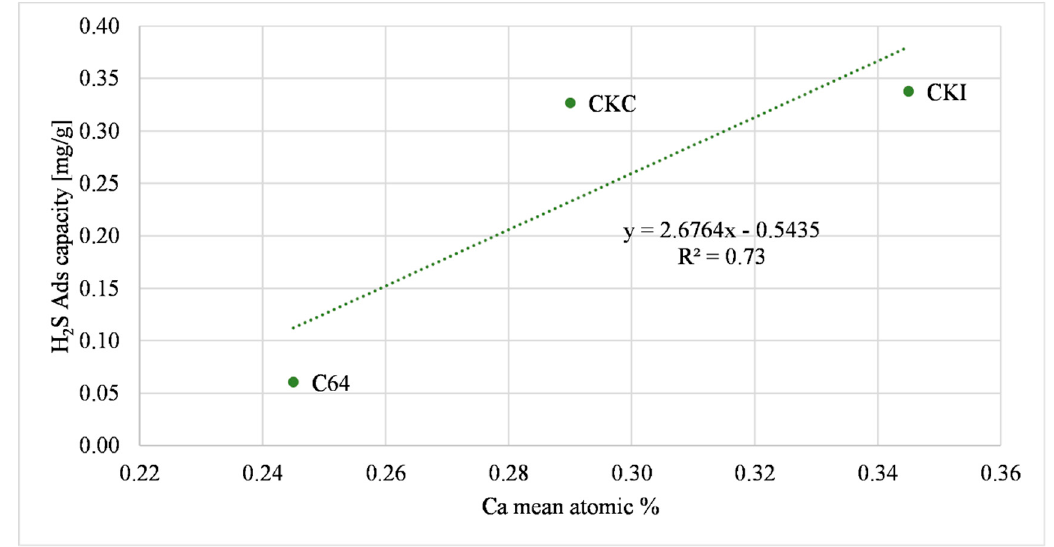
Figure 9. Calcium oxide effect on H 2 S adsorption (AC as received).